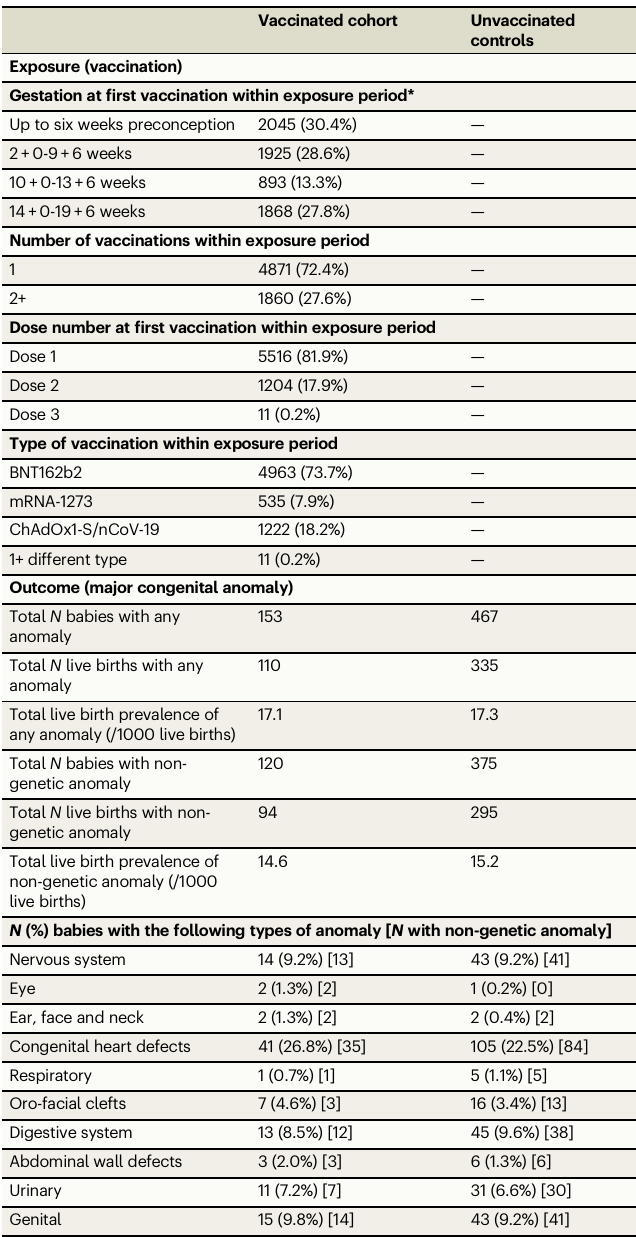
Table 2 | Descriptive information on vaccination (vaccinated group only) and on the risk and types of major congenital anomalies in the vaccinated and controls groups Vaccinated cohort Unvaccinated